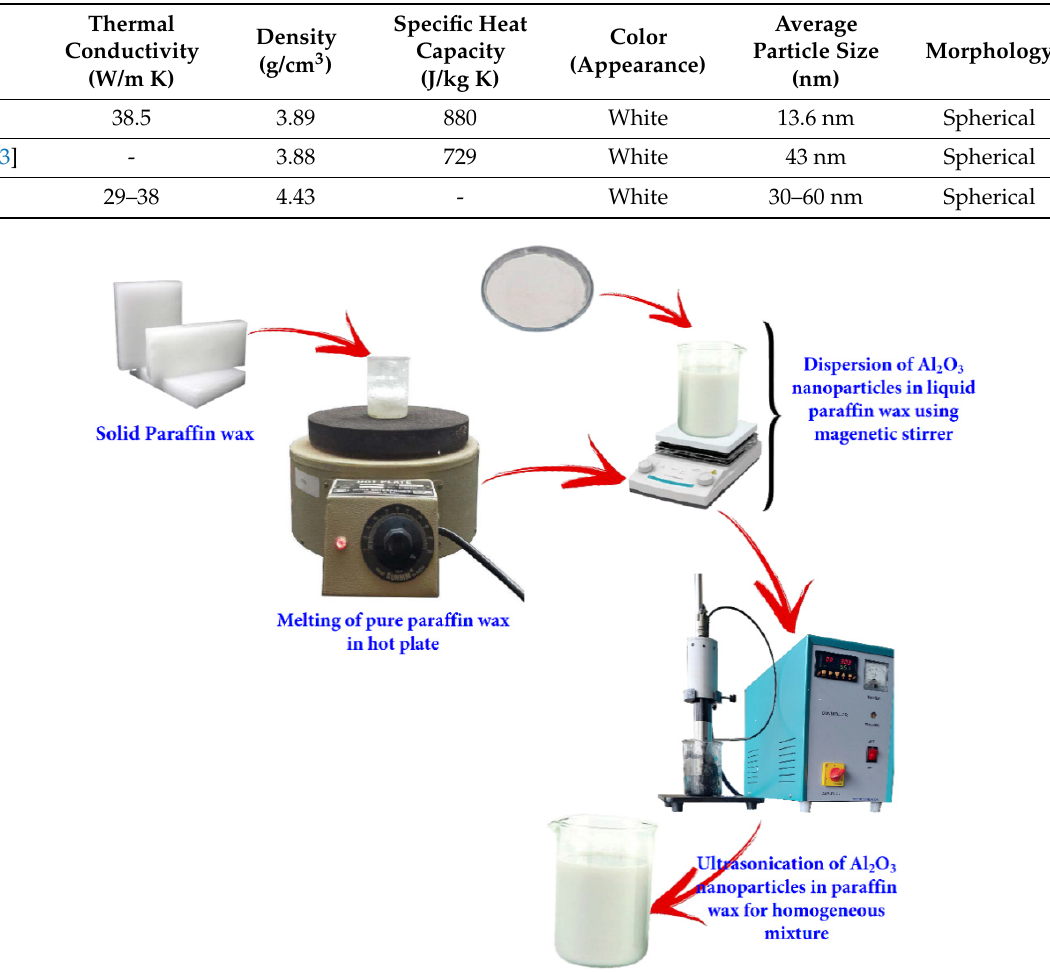
Figure 1. Preparation of paraffin wax with Al 2 O 3 nanoadditive. Table 1. PCM properties (thermophysical).